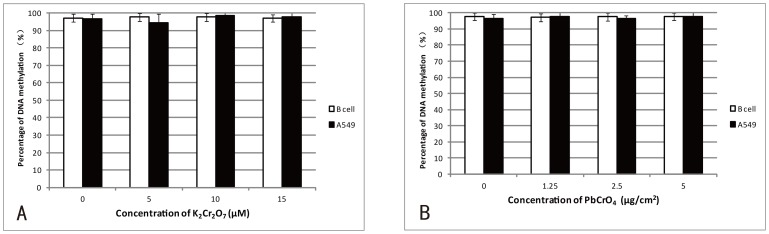
Detection of DNA methylation status at the promoter of p16 gene by pyrosequencing.A: Percentages of methylation at the promoter of p16 gene in human B lymphoblastoid cells and in A549 cells exposed to potassium dichromate at the concentrations of 0, 5 µM, 10 µM, and 15 µM for 24 hours. B: Percentages of methylation at the promoter of p16 gene in human B lymphoblastoid cells and in A549 cells exposed to lead chromate at the concentrations of 0, 1.25 µg/cm2, 2.5 µg/cm2, and 5.0 µg/cm2 for 24 hours.